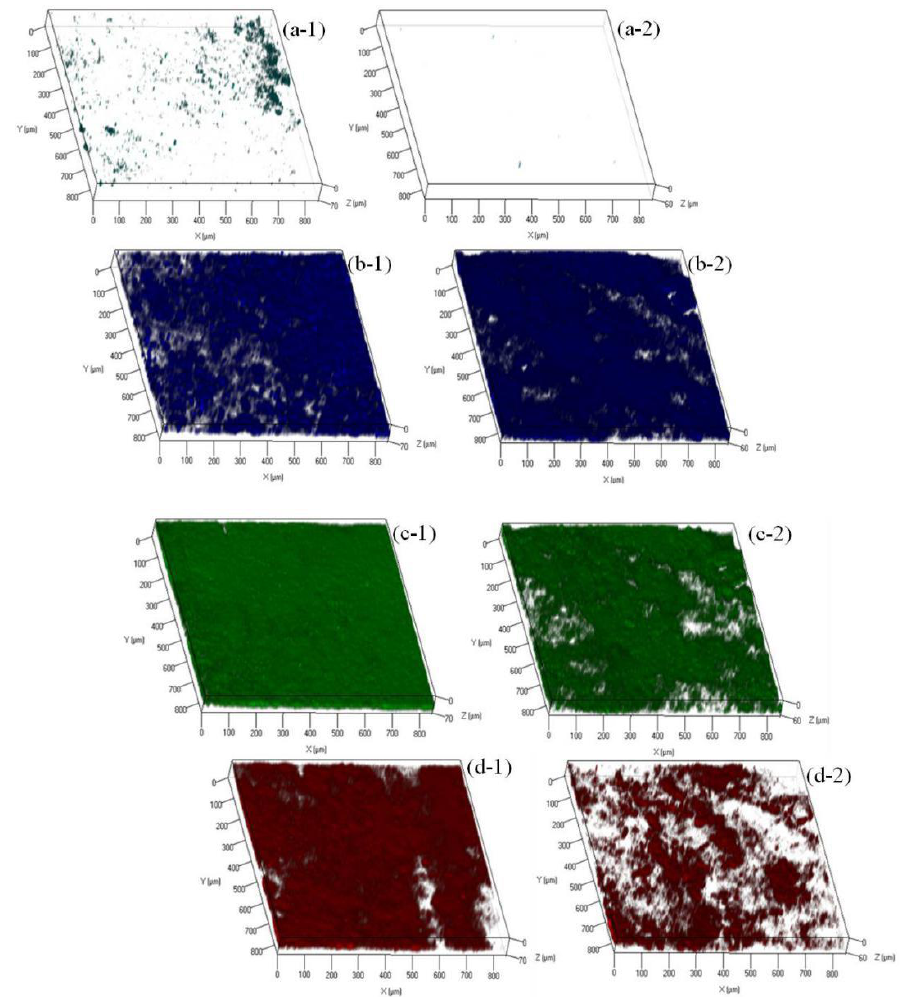
Figure 7. Confocal laser scanning microscopy (CLSM) images of ( a ) α - d -glucopyranose polysaccharides, ( b ) ß- d -glucopyranose polysaccharides, ( c ) proteins, and ( d ) microorganisms in the control ( 1 ) OsMFC and ( 2 ) AgNP-OsMFC .